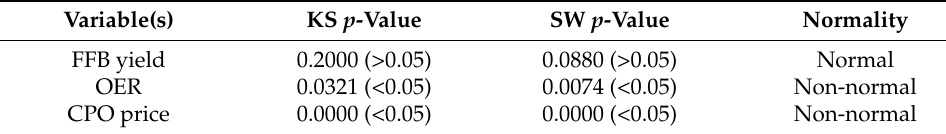
Table 2. Normality tests for the dataset used in this study. Variable(s) KS p -Value SW p -Value Normality FFB yield 0.2000 (>0.05) 0.0880 (>0.05) Normal OER 0.0321 (<0.05) 0.0074 (<0.05) Non-normal CPO price 0.0000 (<0.05) 0.0000 (<0.05)